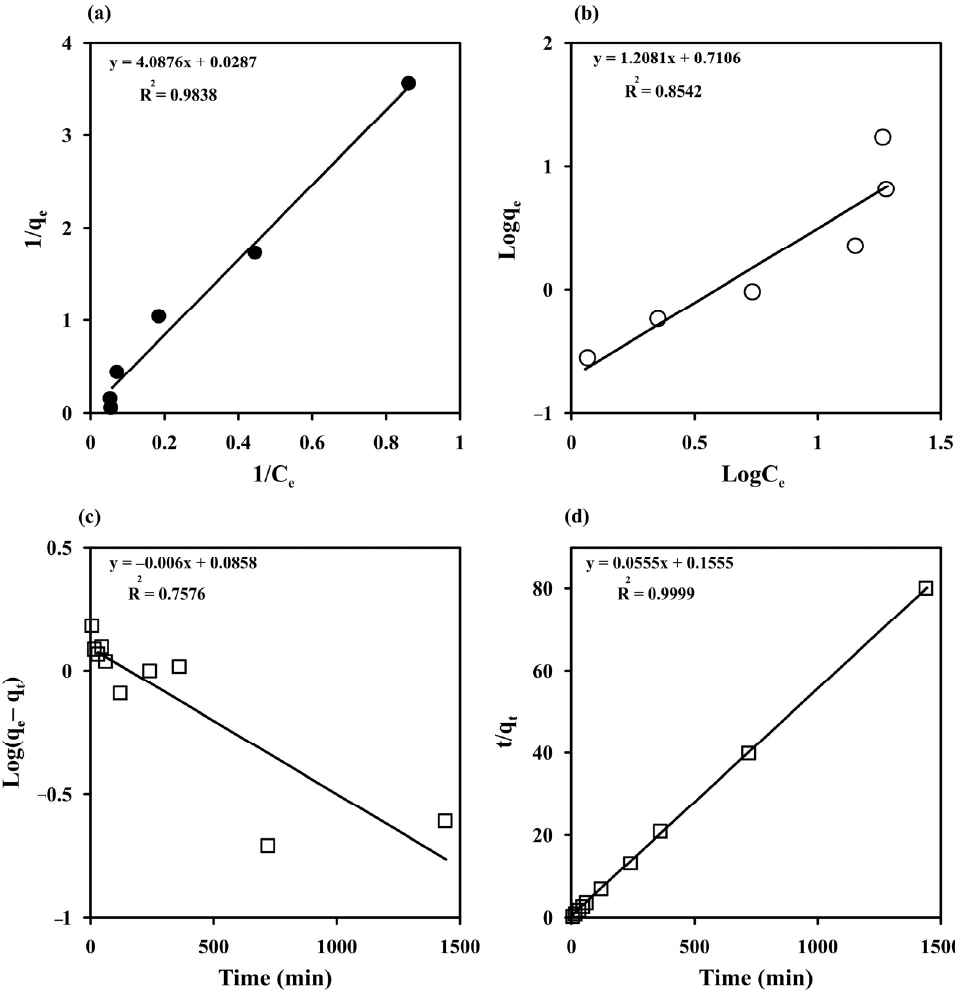
Figure 6. Adsorption isotherm of methylene blue (MB) on starch cryogel ( a ) the Langmuir and ( b ) Freundlich models and its adsorption kinetics ( c ) the Lagergren pseudo-first-order and ( b ) the pseudo-second-order models. Table 1. Parameters derived from applying the Langmuir and Freundlich models to the batch adsorption